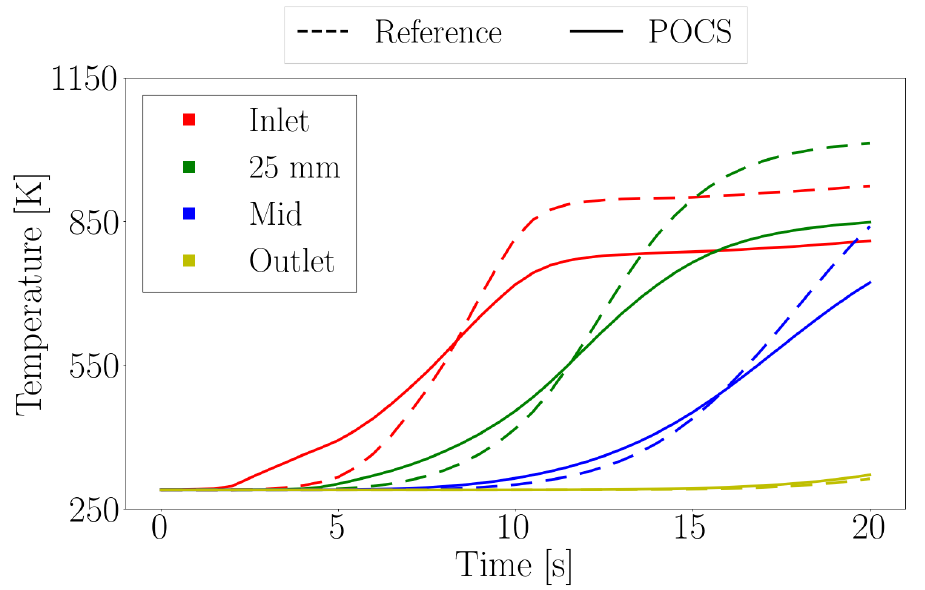
Figure 17. Cold start assessment: CAT1 thermal transient evaluation.